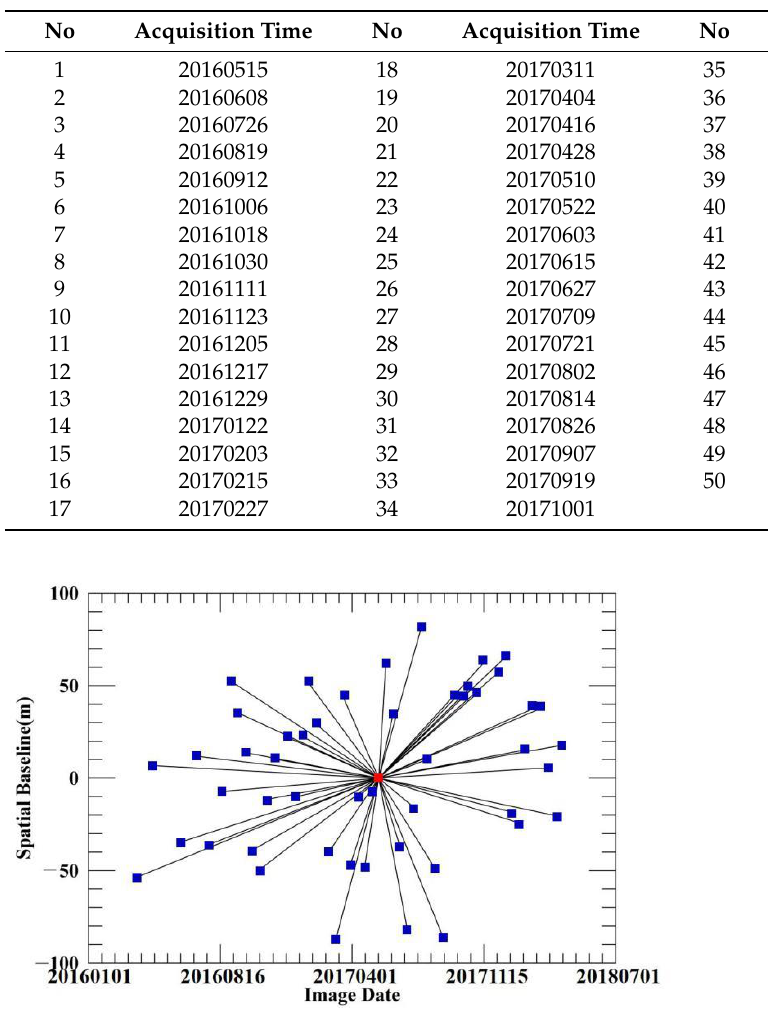
Table 2. The List of SAR data and acquisition times.